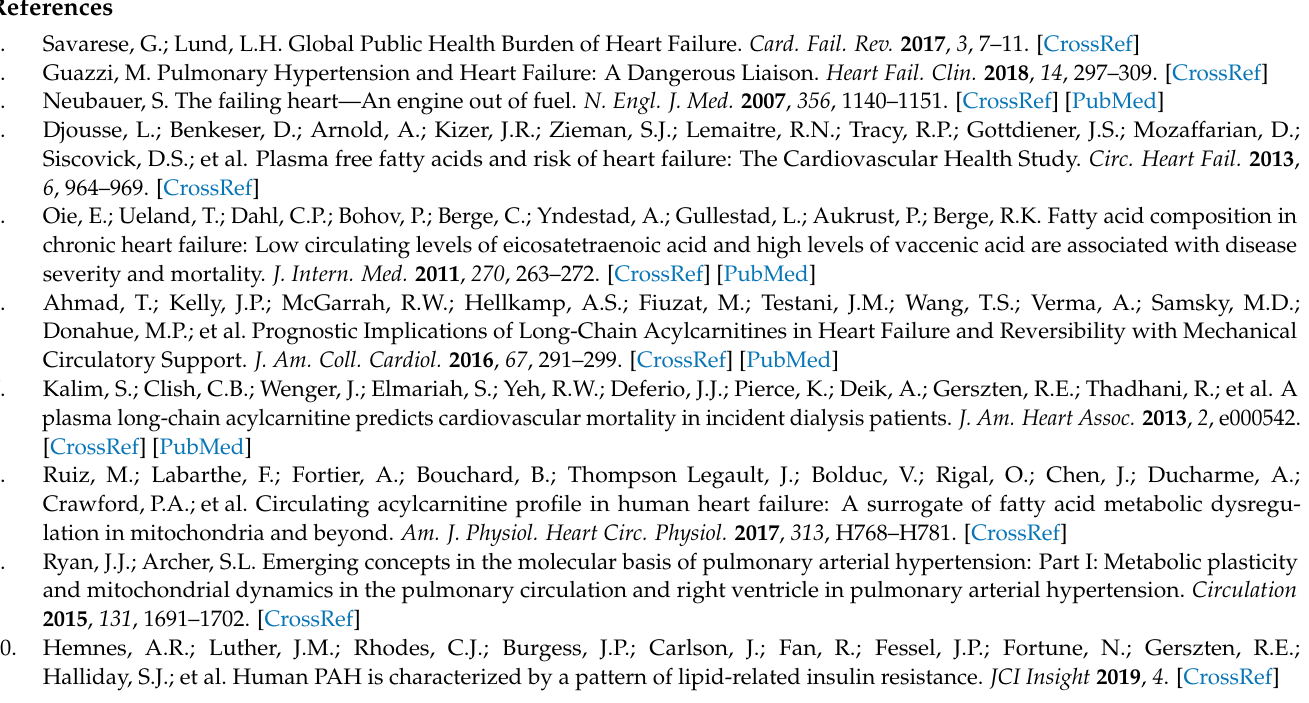
metabolites used for the PCA analysis, Figure S5: Acylcarnitines and fatty acids do not correlate with eGFR in PH-HF and noPH-HF, Table S1: Loading scores from the PCA analysis for the comparison Table S3. Interaction analysis with diuretics treatment, Table S4. Interaction analysis with diabetic (type 2 diabetes)